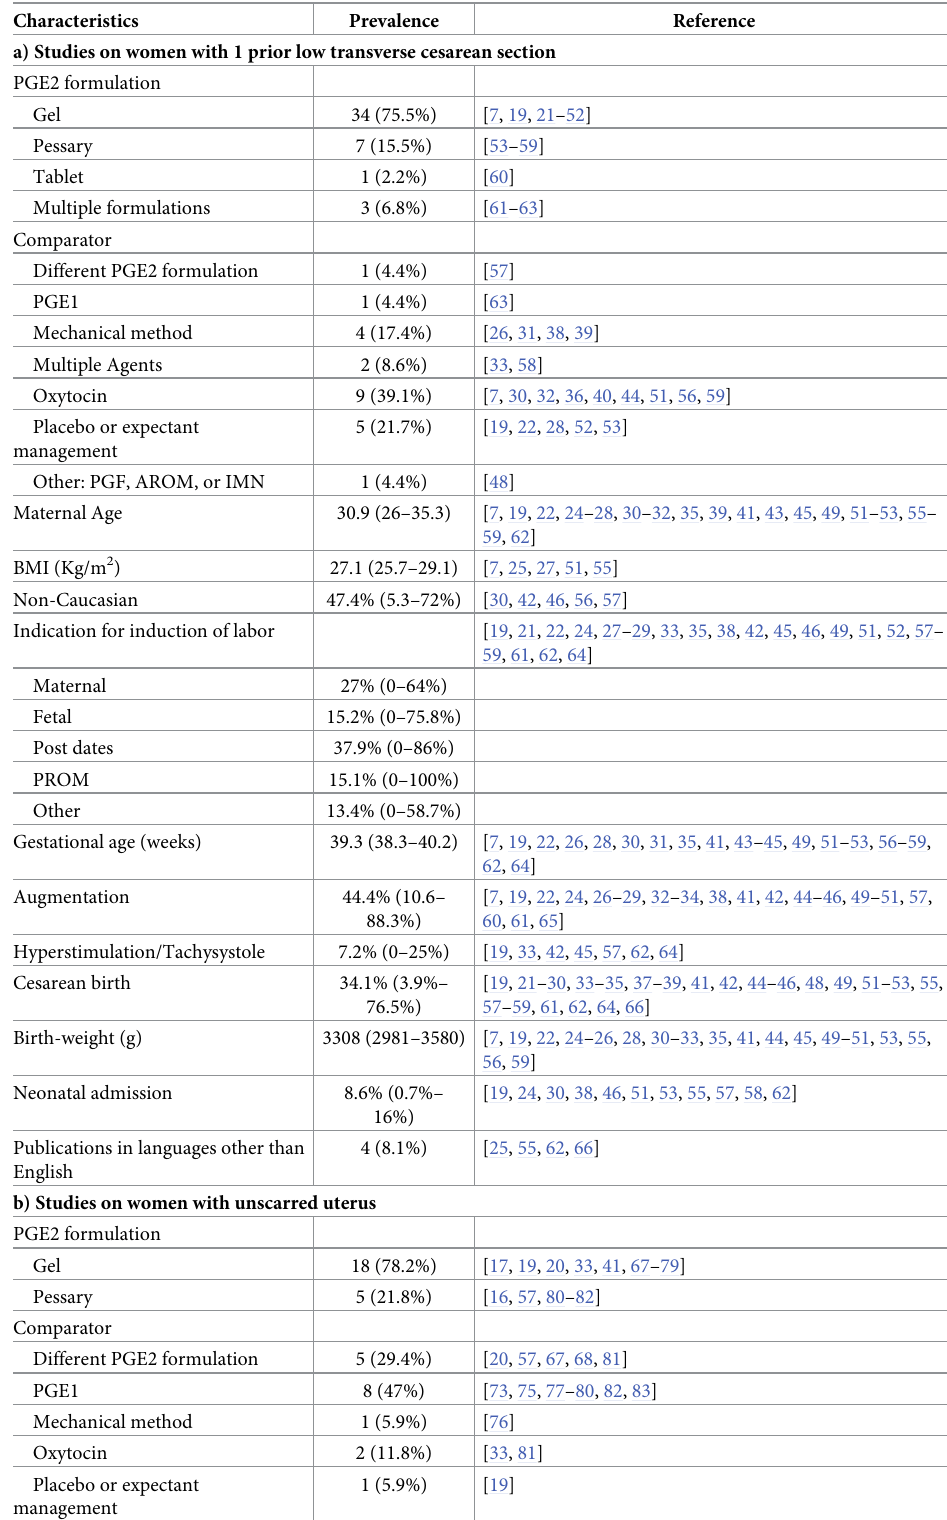
Table 1. Characteristics of the study